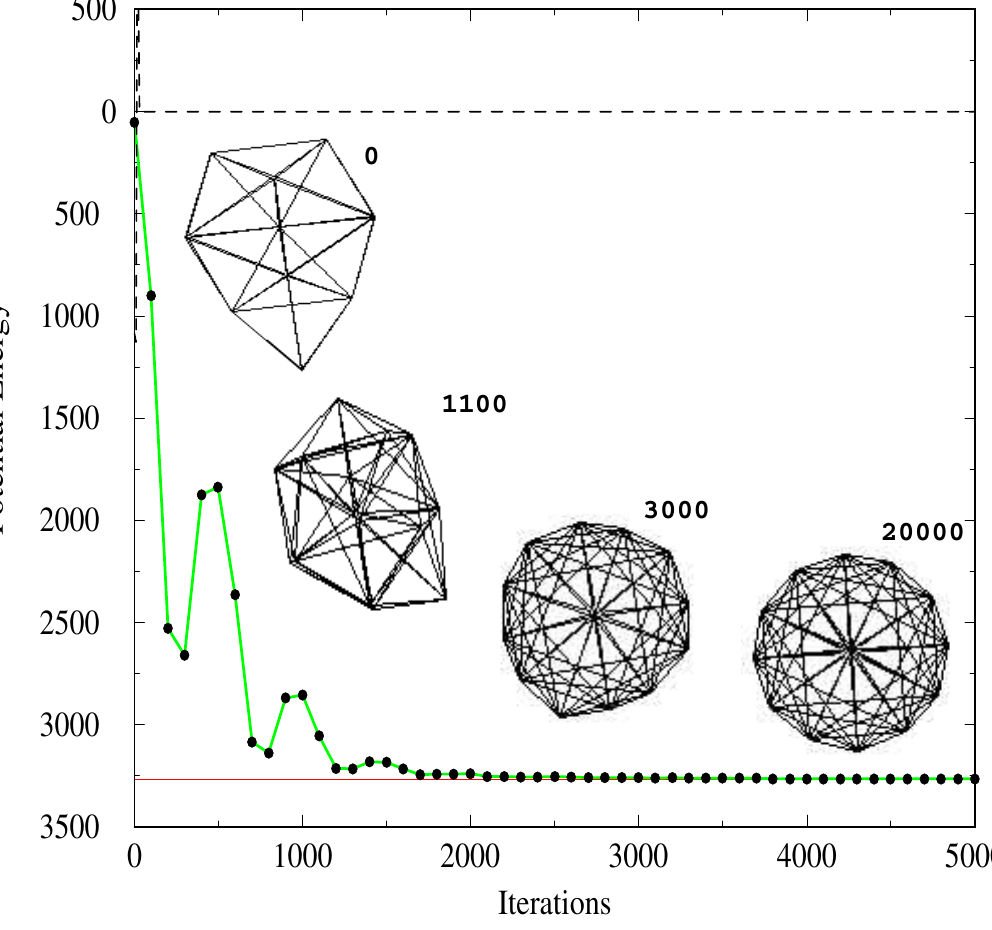
Figure 1: Plot of the potential energy versus iteration number, switching from the Lennard Jones potential to the Sutton Chen. The switching function used is g ( t ) = exp( − ζt ) cos 2 (3 πζt ) with ζ = 0 . 4 and γ = 0 . 1. The time step is 0.01 in units natural to the LJ cluster, for which we also take (cid:15) = σ = 1. At time t = 0 the cluster has the C symmetry. At different times, as indicated, 2 v the cluster configuration is shown, and asymptotically, the configuration reached is the 9–6 Sutton Chen global minimum, with D symmetry. The parameters used for this latter model are taken 6 d from [12]. The dashed line shows the result of the simulation in the absence of switching, namely when the LJ potential is suddenly transformed to the Sutton Chen